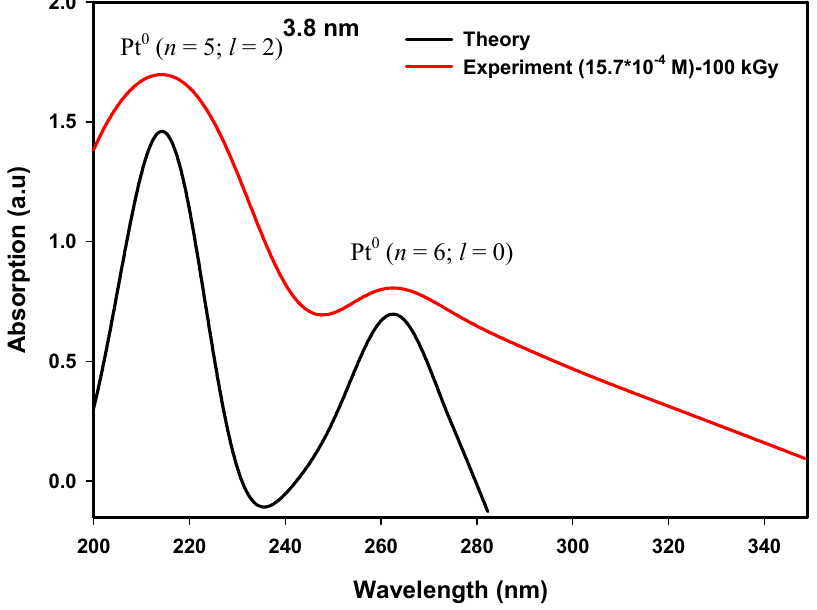
Figure 7. Absorption spectra with absorption maxima of 214.8 and 263.0 nm calculated for an isolated Pt nanoparticle of diameter 3.8 nm. The absorption peaks of 214.8 and 263.0 nm are attributed to the intra-band electronic transitions from conduction band energy states of ( n = 5; l = 2) and ( n = 6; l = 0) to higher energy states of ( n ≥ 6; Δ l = 0, ±1; Δ s = 0, ±1) and ( n ≥ 7; Δ l = 0, ±1; Δ s = 0, ±1) respectively, allowed by the principle of quantum numbers. Also shown is the measured UV absorption spectra with absorption maxima of 214.8 and 262.3 nm of colloidal Pt nanoparticles synthesized at 100 kGy, which produced Pt nanoparticles of average size of 3.8 nm (Table